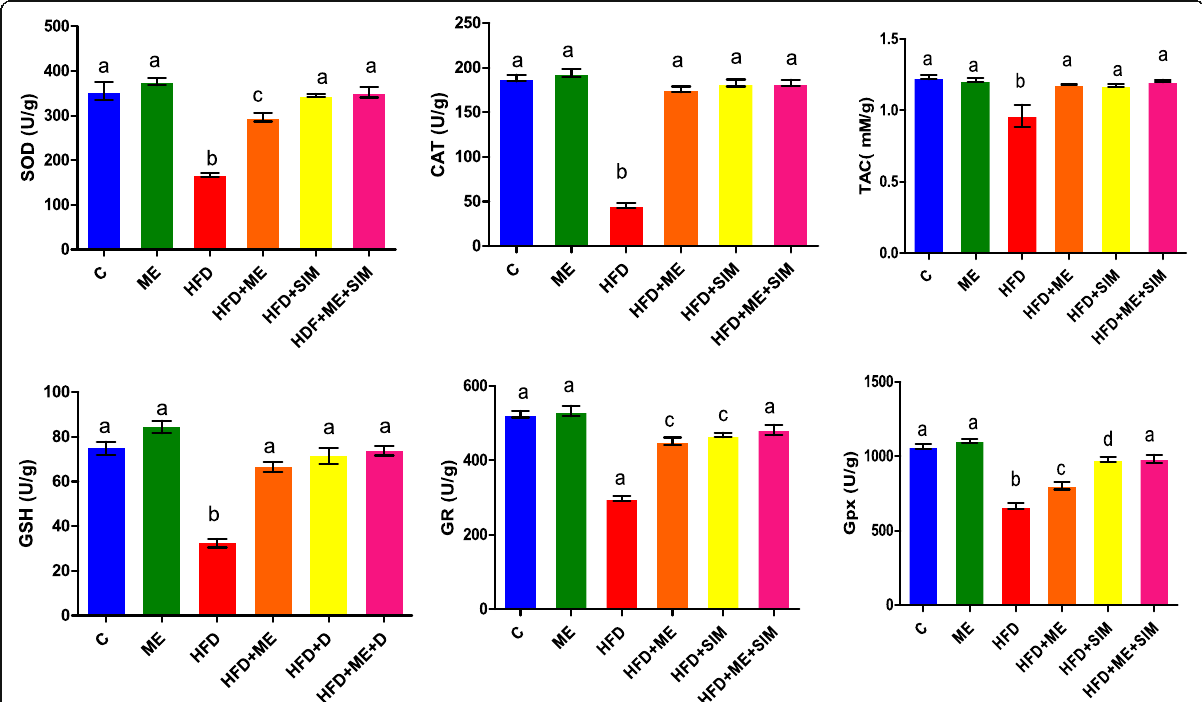
Fig. 6 The effects of Moringa leaf extract (ME), simvastatin (SIM) and their combination (ME+SIM) on glutathione (GSH) concentration, superoxide dismutase (SOD), catalase (CAT), glutathione reductase, and glutathione peroxidase activities and total antioxidant capacity in livers of rats fed a high-fat diet (HFD) for 6 weeks. ME protected liver tissue as indicated by the maintenance of comparable activities to the control. Different letters indicate significant differences between groups (p < 0.05). Values are means ±SD (n =